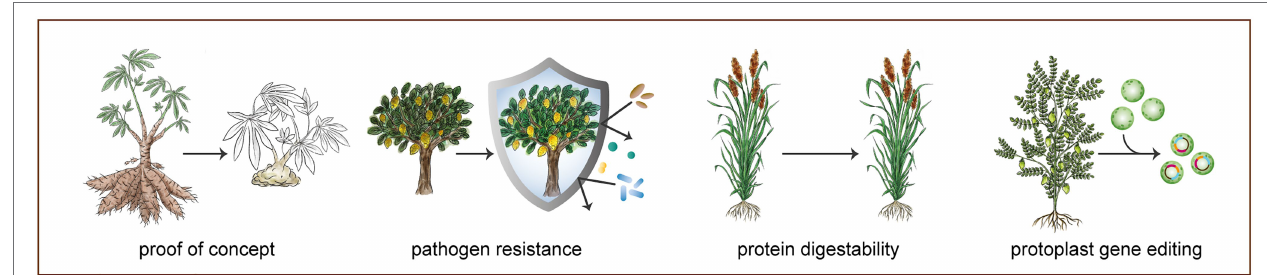
FIGURE 1 | Selection of gene editing applications in orphan crops. Successful demonstration of gene editing in orphan crops ranges from targeting drought response-related genes in chickpea protoplasts to functional knockout of phytoene desaturase ( PDS ) in cassava. More agronomically important applications of CRISPR/Cas have produced traits, such as increased protein digestibility in sorghum, achieved through knocking out a highly homologous set of related genes ( k1C gene family). Another widely studied application of CRISPR/Cas is the functional knockout and promoter editing of Lateral organ boundaries 1 ( LOB1 ) gene in citrus, resulting in citrus canker bacterial resistance. See Supplementary Table 1 for a complete overview of gene editing applications in orphan and underutilized